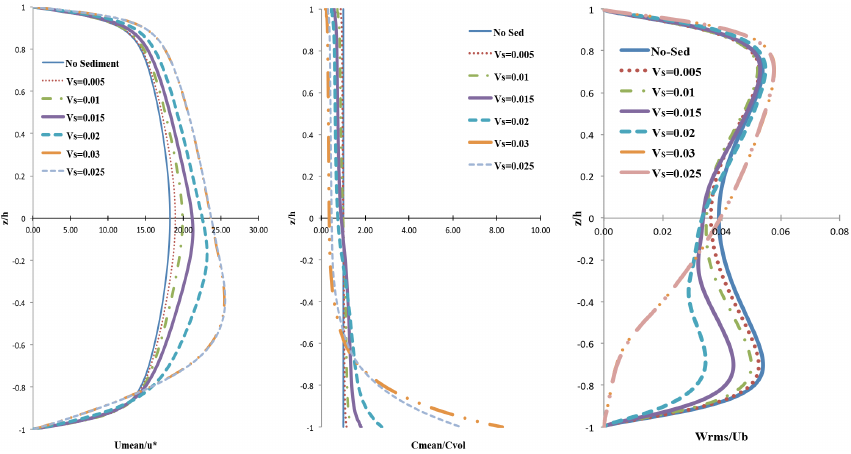
Figure 2. Results from the DNSs in a channel flow setting, for increasing ˜ V and Ri τ = 18. The mean streamwise velocity and asymmetry of the flow increase with increase in ˜ V . Increase in ˜ V increases the degree of self-stratification of the flow; this leads to increase in the sediment concentration gradient and higher amount of turbulence damping near the channel bottom. In the channel, normalized turbulence intensity ( W rms /U b ) is modulated, with a decrease in the lower half of the channel and slight increase in the upper half of the channel.